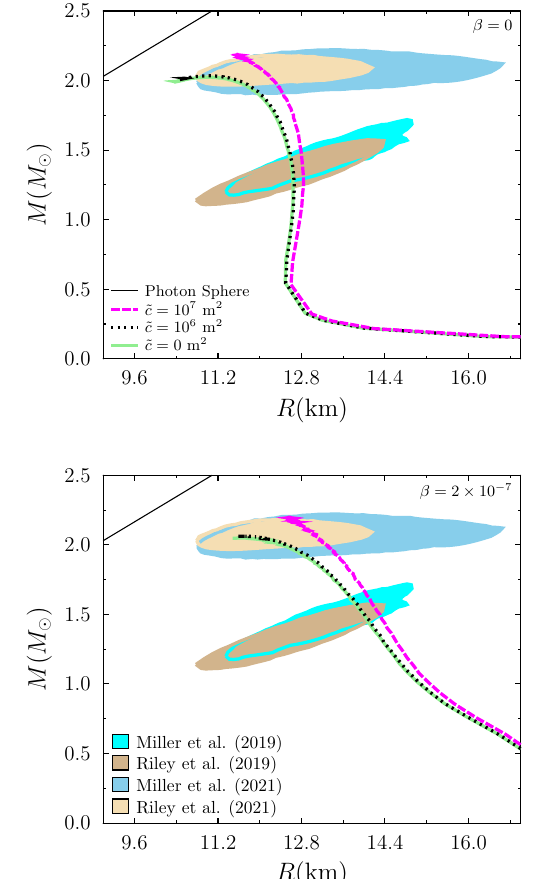
Fig. 5 Themass–radiusrelationwhen ˜ c valueisvaried.Thedatashape, which are NICER data of PSR J0030+0451 ( M ∼ 1 . 4 M (cid:4) ) [65,66] and PSR J0740+6620 ( M ∼ 2 . 1 M (cid:4) ) [67,68], are taken from Ref.